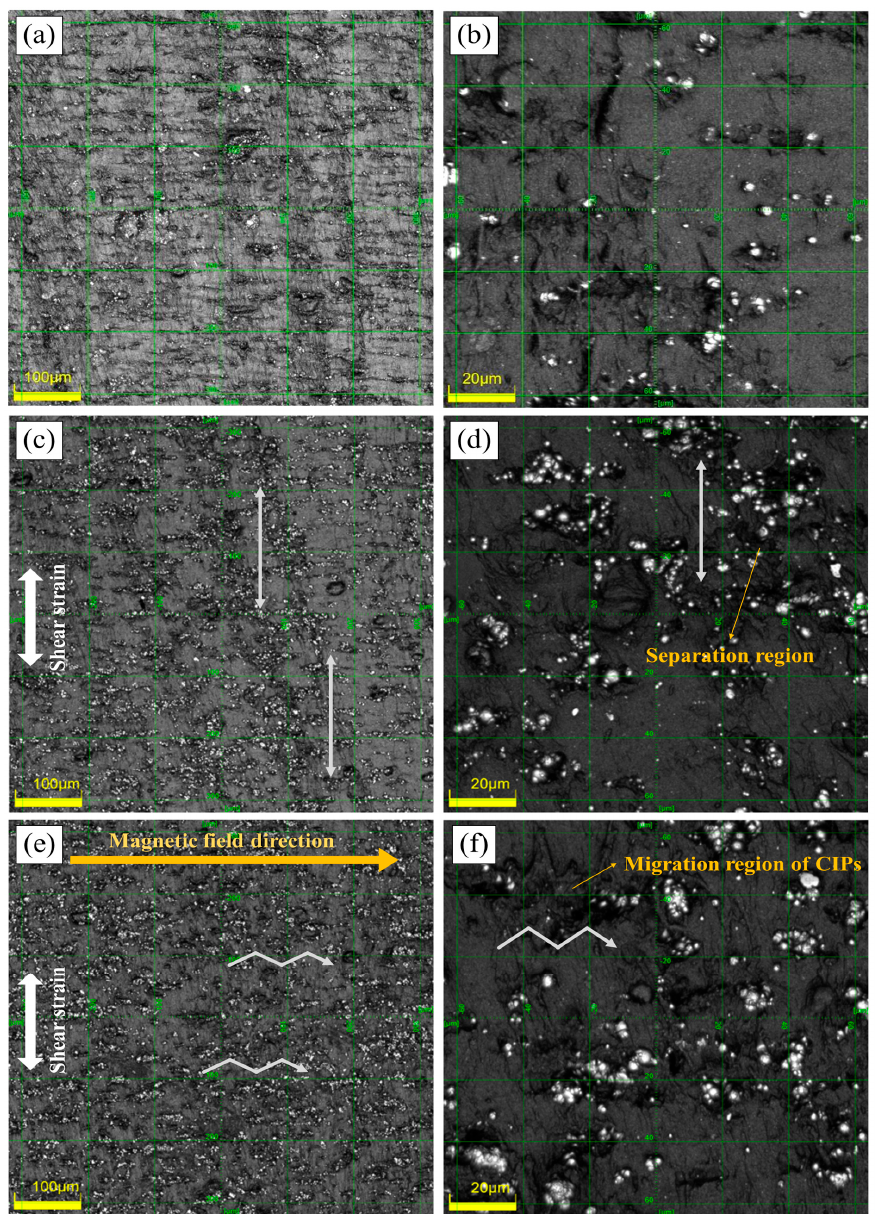
Figure 2. Microscope images with ( a ) 20× and ( b ) 100× magnification of the initial MRE cross-section; and ( c ) 20× and ( d ) 100× magnification of the MRE cross-section after the cyclic shear fatigue in the zero field; and ( e ) 20× and ( f ) 100× magnification of the MRE cross-section after 500,000 shear fatigue cycles under magnetic field. The bright parts represent the magnetic particles embedded in the NR. The white arrows represent the direction of separation or migration regions.